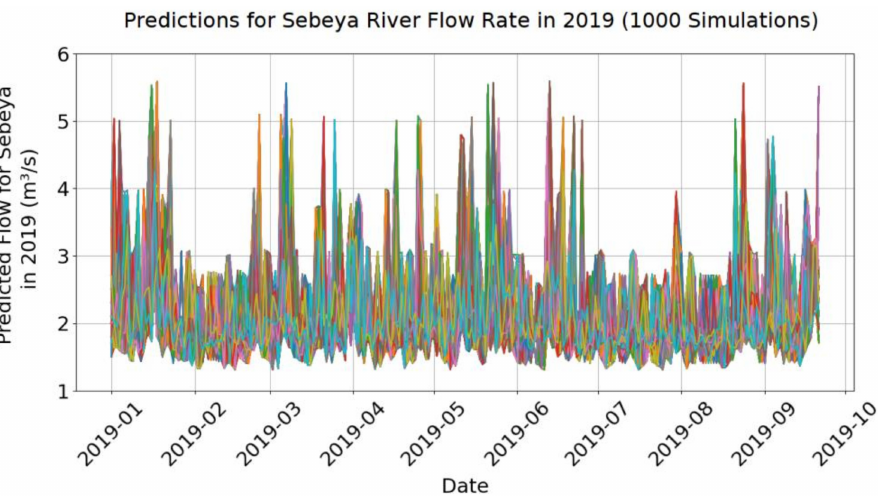
Figure 4. Adjusted predictions for the Sebeya river flow in 2019. In the chart, each of the one thousand simulations performed is represented by a line in a different color. All 1000 iterations are overlaid in the figure. Vertical width on any time step illustrates the randomized range of the river flow rate for each time